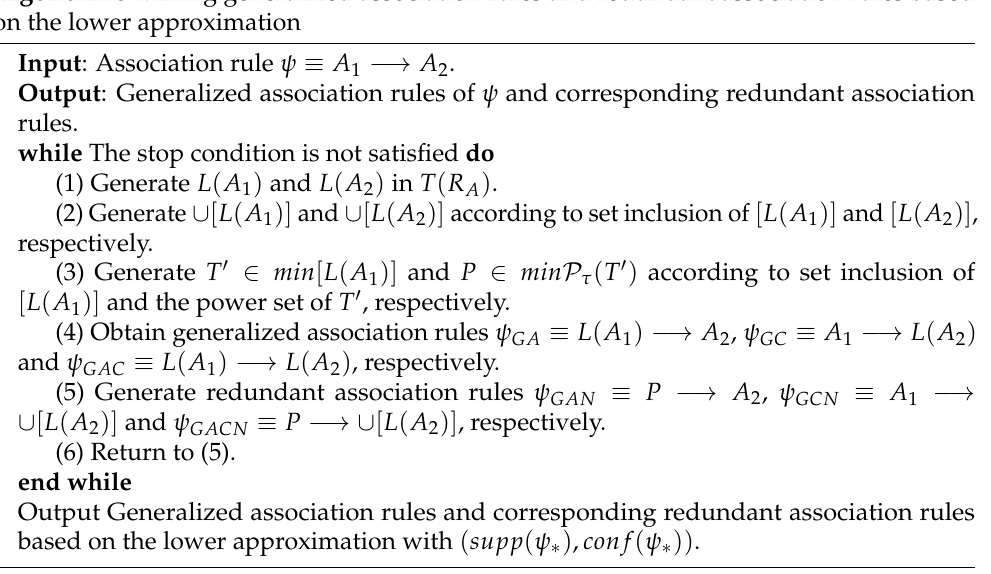
Algorithm 3 Mining generalized association rules and redundant association rules based on the lower